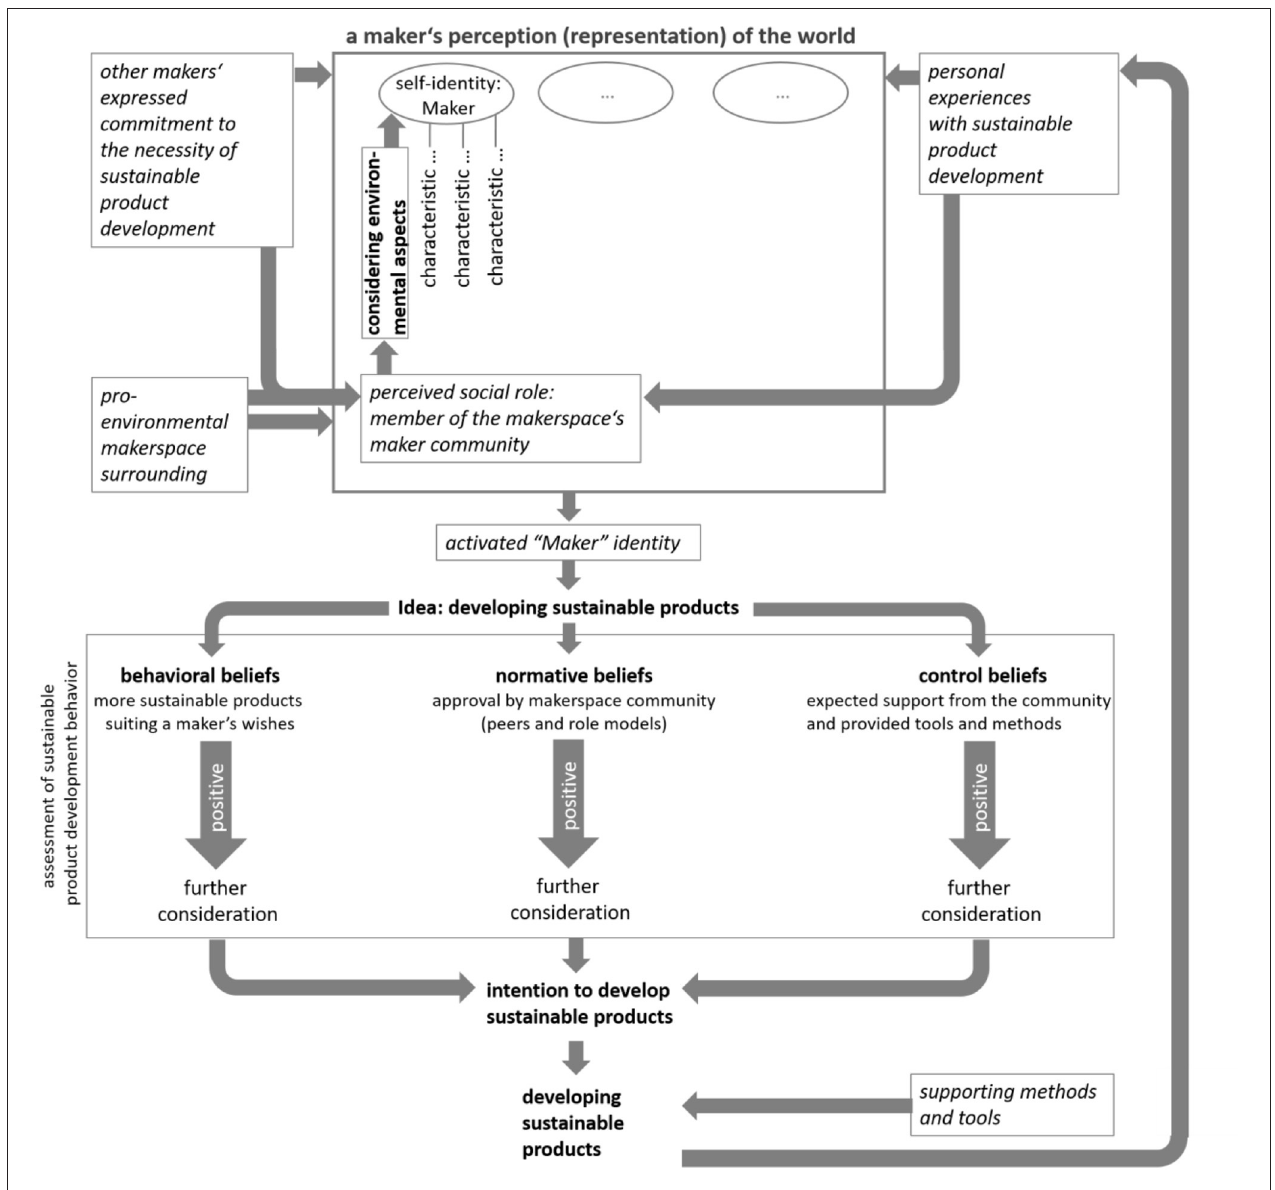
FIGURE 3 | Theoretical framework of pro-environmental decision-making process in